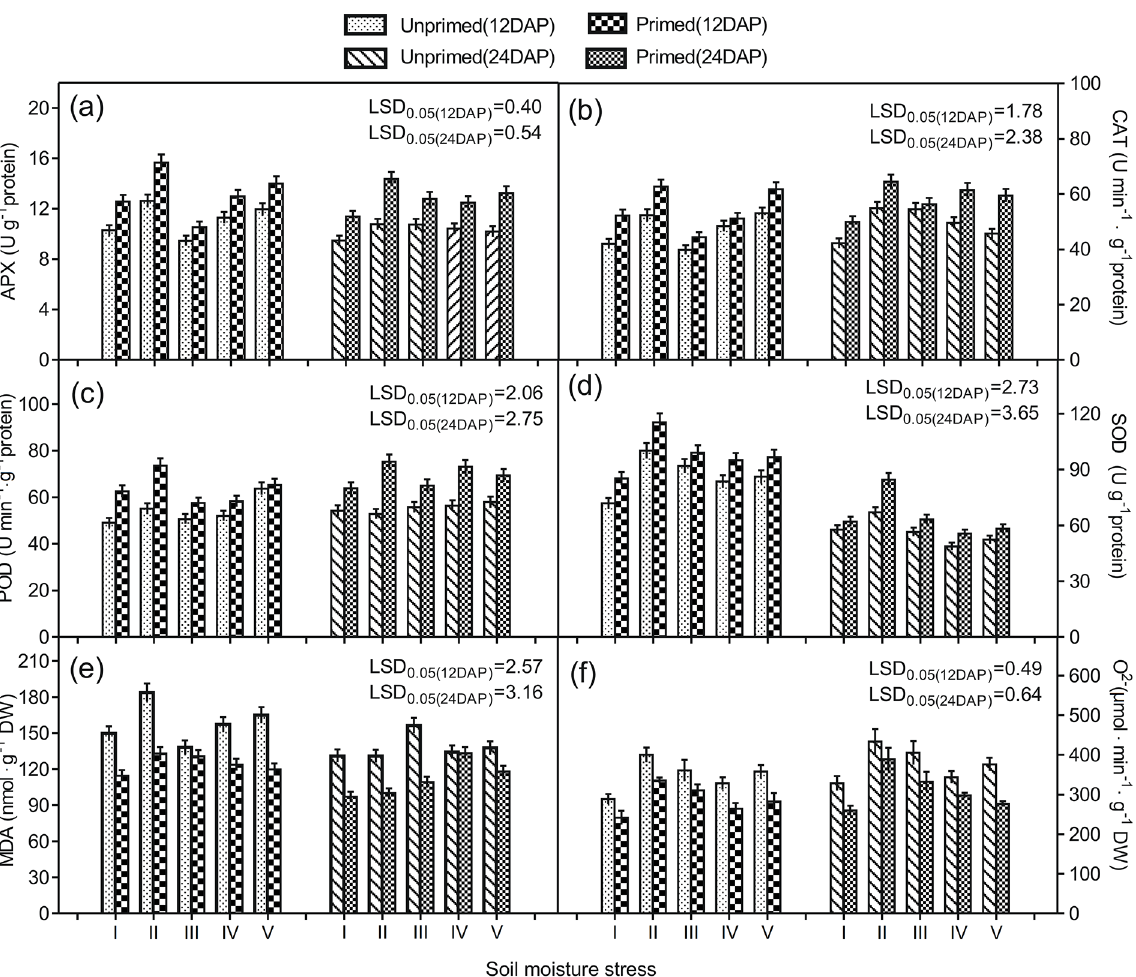
Fig 1. Effect of seed priming with PEG and soil moisture stress on sorghum APX, CAT, POD, SOD, MDA, and O 2 − activities. (a) Ascorbate peroxidase (APX), (b) catalase (CAT), (c) malondialdehyde (MDA), (d) hydrogen peroxide (H 2 O 2 ), (e) peroxidase (POD), and (f) superoxide dismutase (SOD) activities in sorghum seedlings. Unprimed or primed sorghum seeds were germinated under (I) unstressed soil moisture environment (Unstressed control), (II) drought, (III) excessive soil moisture stress (EM), (IV) 8 d drought stress followed by EM, and (V) 8 d EM followed by drought stress. Measurements were conducted at 12 and 24 days after planting (DAP). Data presented are means ± standard